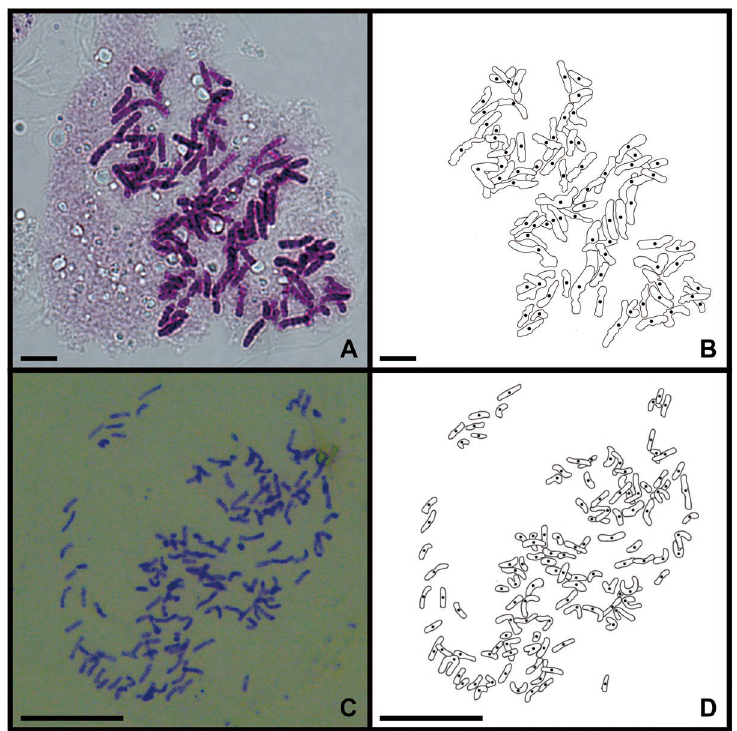
Figure 1. Chromosomes of C. thalictroides in mitotic root-tip cells (scale bars = 20 µ m). ( A ) Metaphase chromosome of the diploid, 2 n = 78; ( B ) Lined drawing of Figure A; ( C ) Metaphase chromosome of the triploid, 2 n = 117; ( D ) Lined drawing of Figure